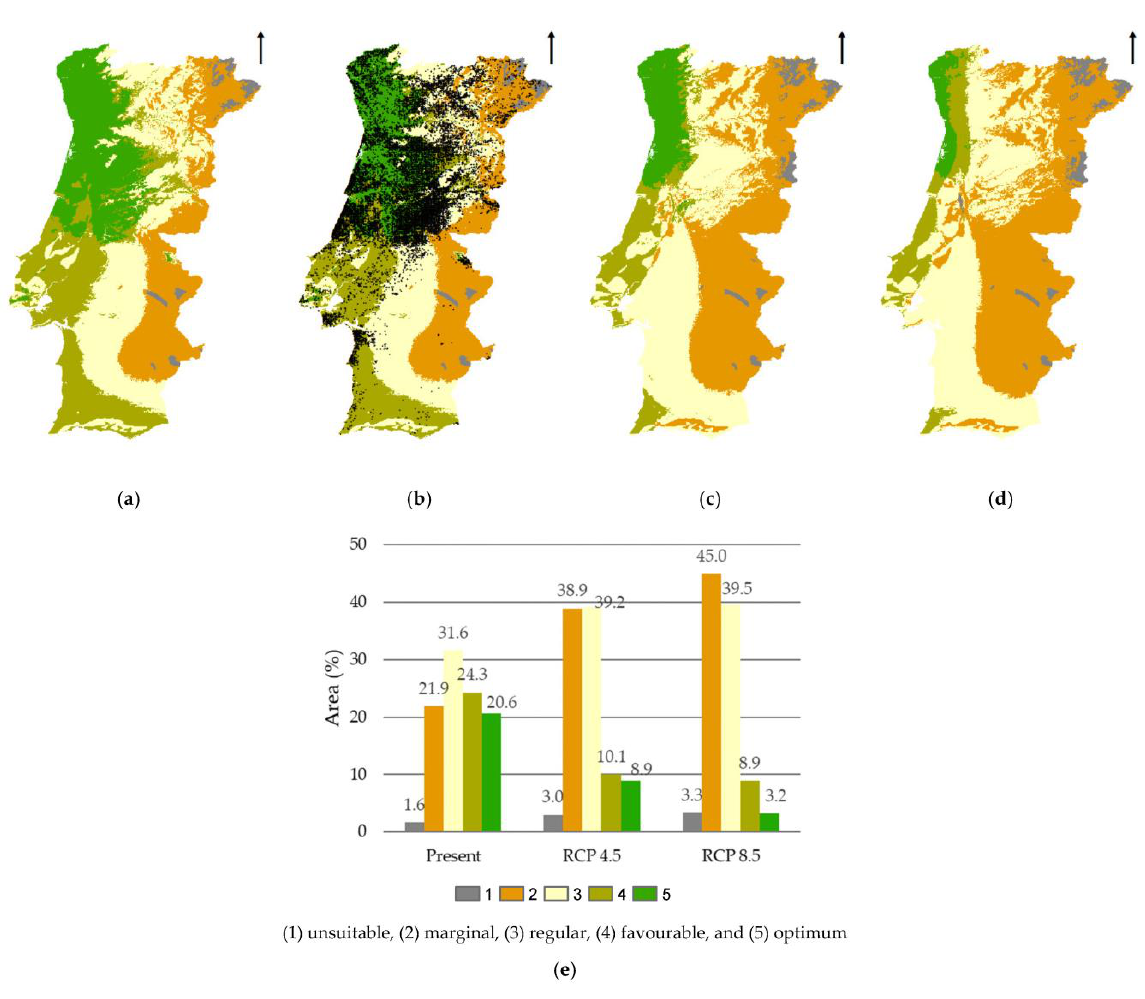
Figure 8. Ecological envelope — Maritime pine potential distributions for the present and for the future under climate change scenarios: ( a ) Present; ( b ) Present with the species’ occurrences (black dots); ( c ) Future 2070 — RCP 4.5; ( d ) Future 2070 — RCP 8.5; and ( e ) Suitability areas (%) in the present